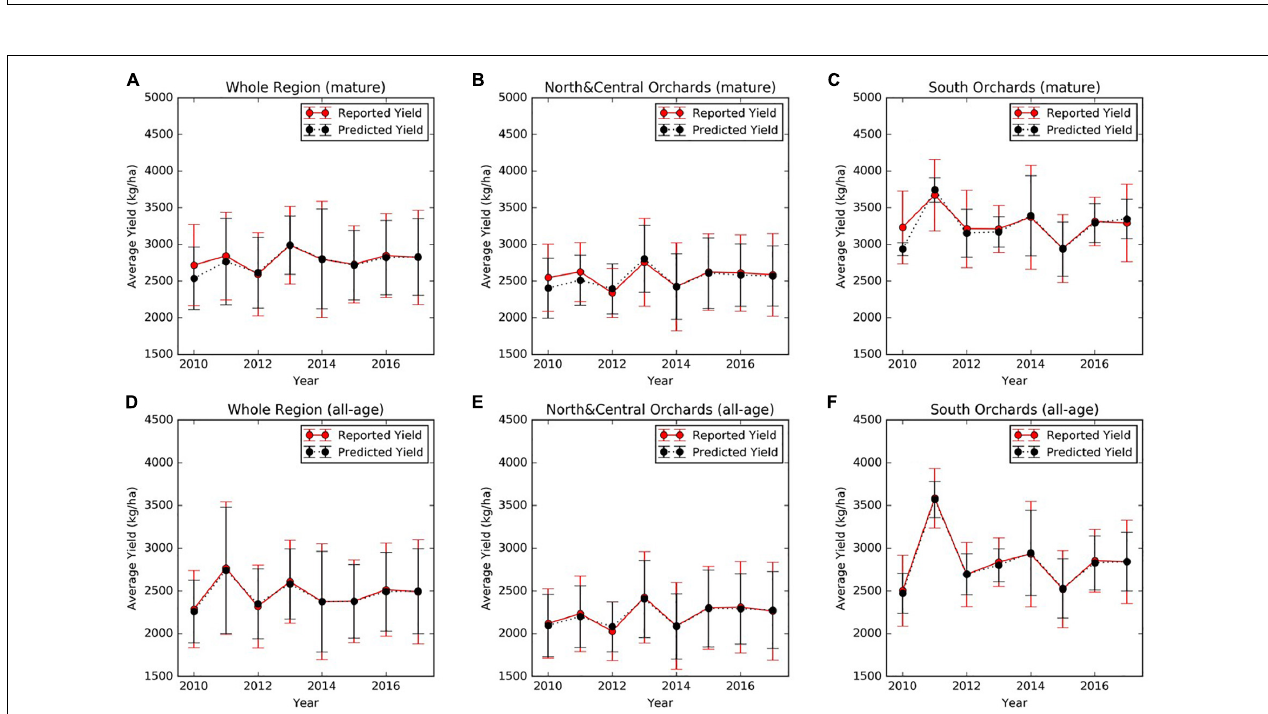
FIGURE 4 | Historical yield patterns for two sample orchards, Orchard #1 is located in Colusa County, planted in 2001 (black), and Orchard #2 is located in Kern County, planted in 2006 (blue). The corresponding early season predictions were also shown as (a) dashed lines by the full model and (b) dotted lines by the reduced model excluding the historical yield and cultivar composition from predictors.